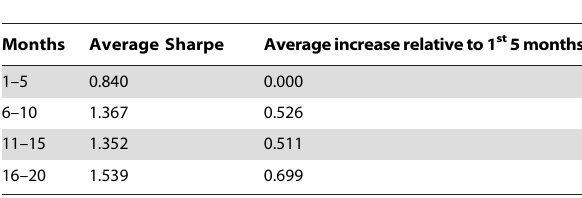
Table 1. Evolution of individual Sharpe Ratios over a 20-month